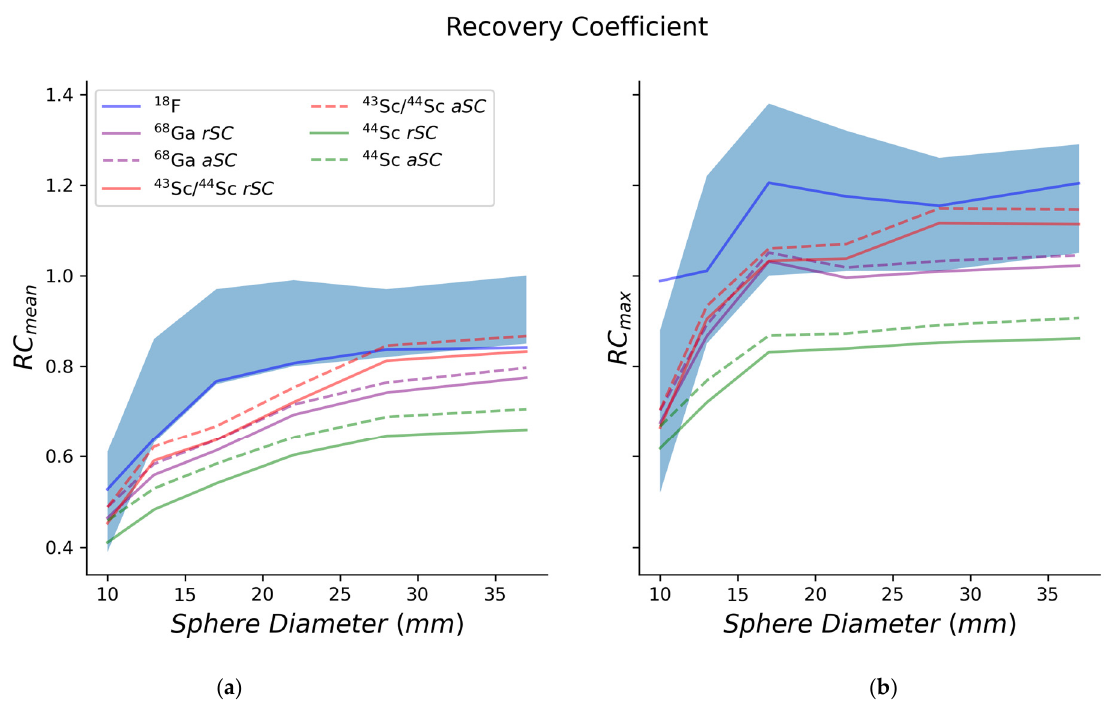
Figure 5. Mean ( a ) and maximum ( b ) recovery coefficients ( RC s) for the NEMA phantom. The EARL RC ranges for [ 18 F]FDG PET were used for comparative purposes.